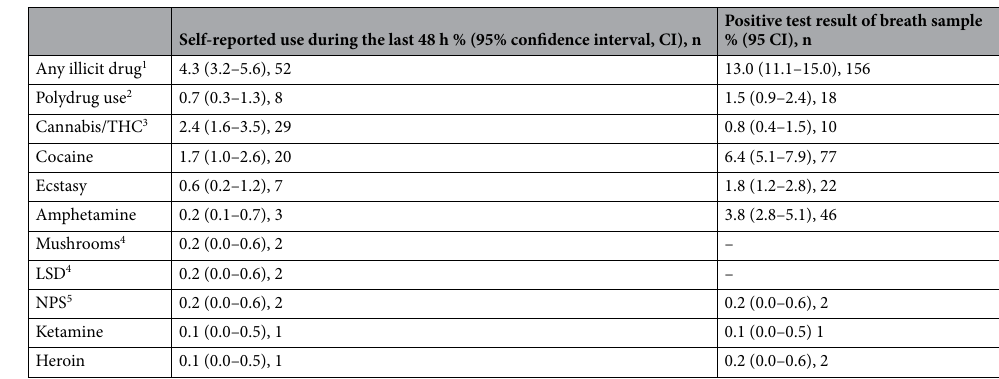
Table 2. Prevalence of the recent use of illicit drugs obtained by self-reporting and drug test results of exhaled breath samples (n = 1223). 1 Self-reported drug use of at least one substance listed in the table. Positive test result of at least one of the 47 substances tested. 2 Self-reported use of two or more drugs during the last 48 h by the same individual. Positive test results of two or more drugs within the sample. 3 Analyses of breath samples can only detect cannabis used within approximately the last 6 h. 4 Magic mushrooms and LSD were not tested for in the breath samples. 5 Of the four compounds previously defined as new psychoactive substances (NPS), two were found in the breath samples: pentedrone (n = 2), alpha-PVP (n = 2), within the same two subjects. In addition, the following drugs were found in the samples: methylphenidate (n = 7), Methamphetamine (n = 1), MDA (n = 1), Oxazepam (n = 1), Temazepam (n = 2), Pregabalin (n = 2), Gabapentin (n = 1), Tramadol (n = 1), Oxycodone (n = 1), Zopiclone (n = 1), Methadone (n = 1). Participants, n = 1,223. Regarding self-reported data, data was missing for n = 13 (any illicit drug, polydrug use), n = 34 (cannabis), n = 31 (cocaine), n = 29 (ecstasy), n = 21 (amphetamine), n = 16 (mushrooms, LDS, ketamine), and n = 18 (NPS, heroin). Breath samples were not obtained from 19 participants.